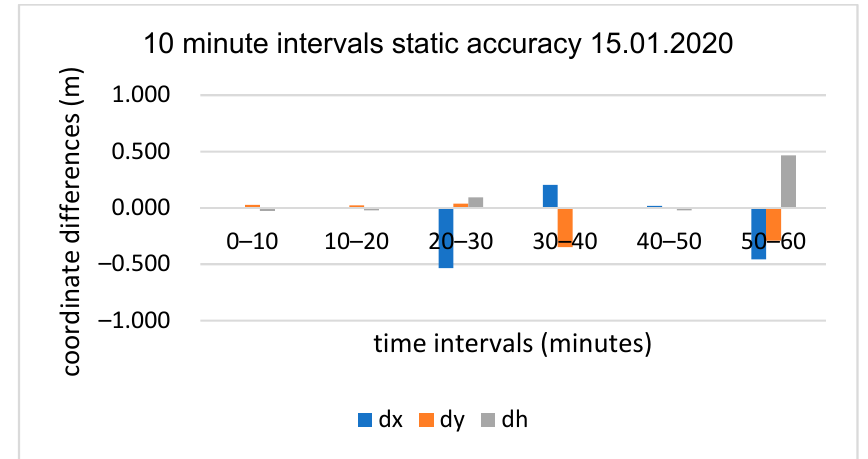
Figure 6. 10 min sub-session positioning results for initial test, baseline OPNT–P30Pro (4 km). OPNT: Olsztynski Park Naukowo-Technologiczny; dx, dy, dh: coordinate differences between the true position and smartphone static results in north (dx), east (dy) and height (dh) components, respectively.